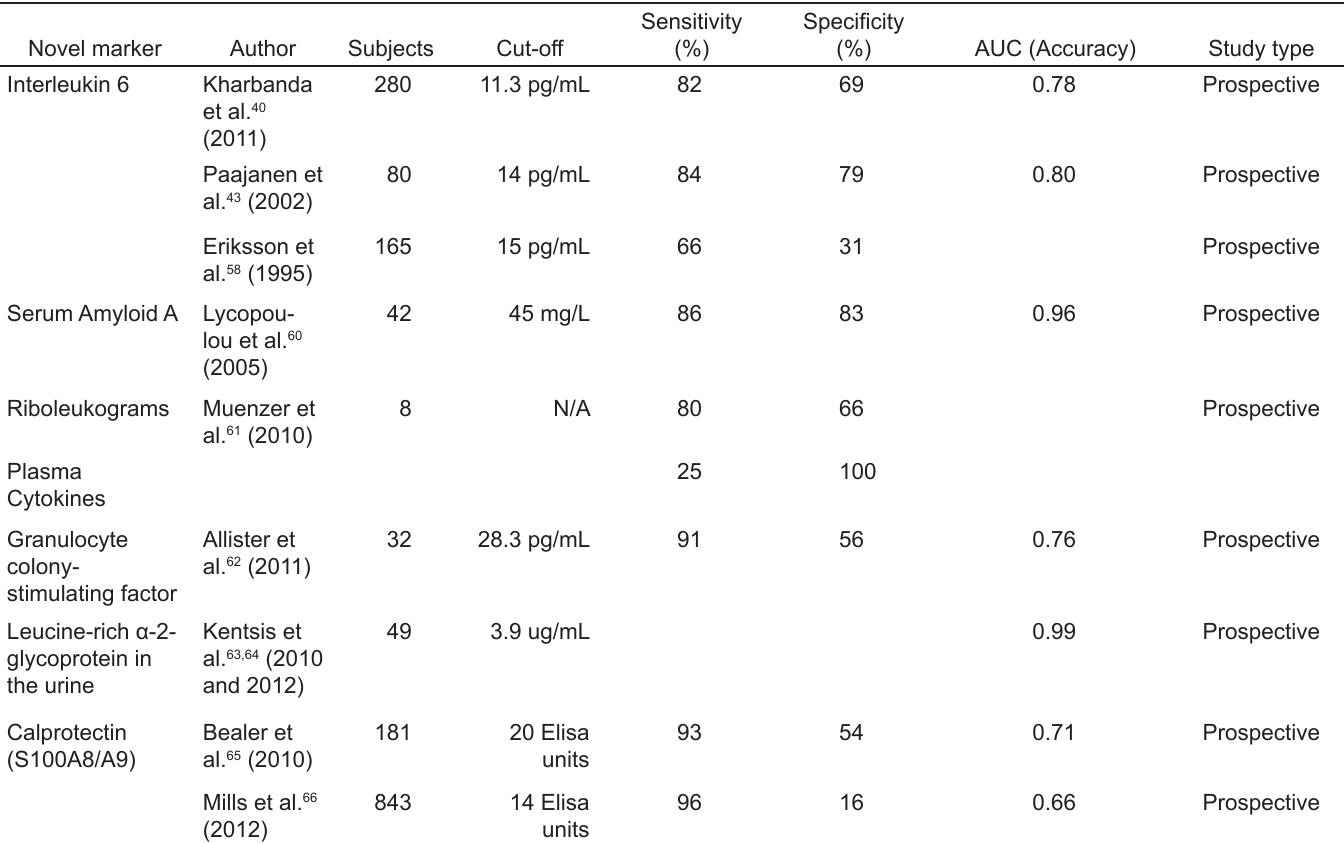
Table 5 . Operating characteristics for novel markers in predicting appendicitis